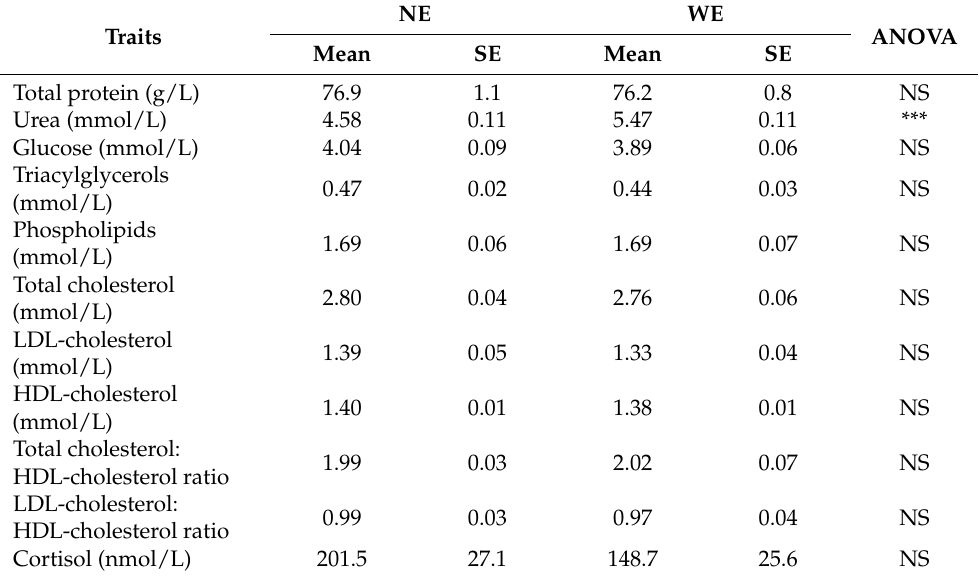
Table 2. Plasma parameters from Alentejano pigs kept on individual pens without